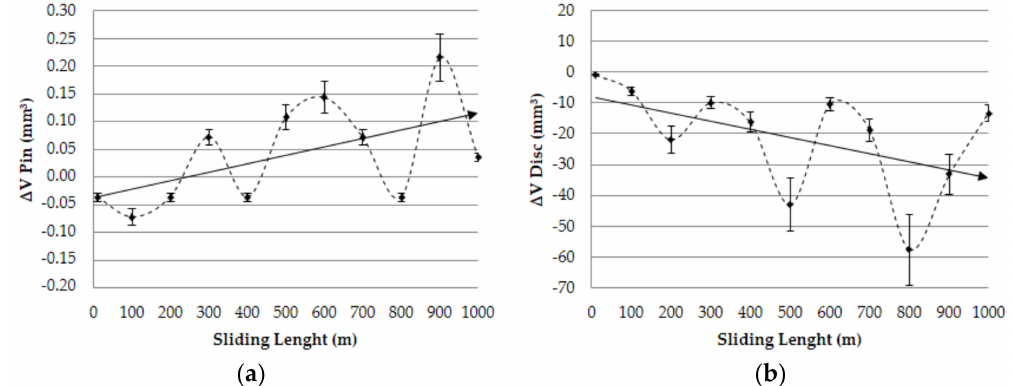
Figure 8. Volume variation vs. sliding length: ( a ) pin; ( b )